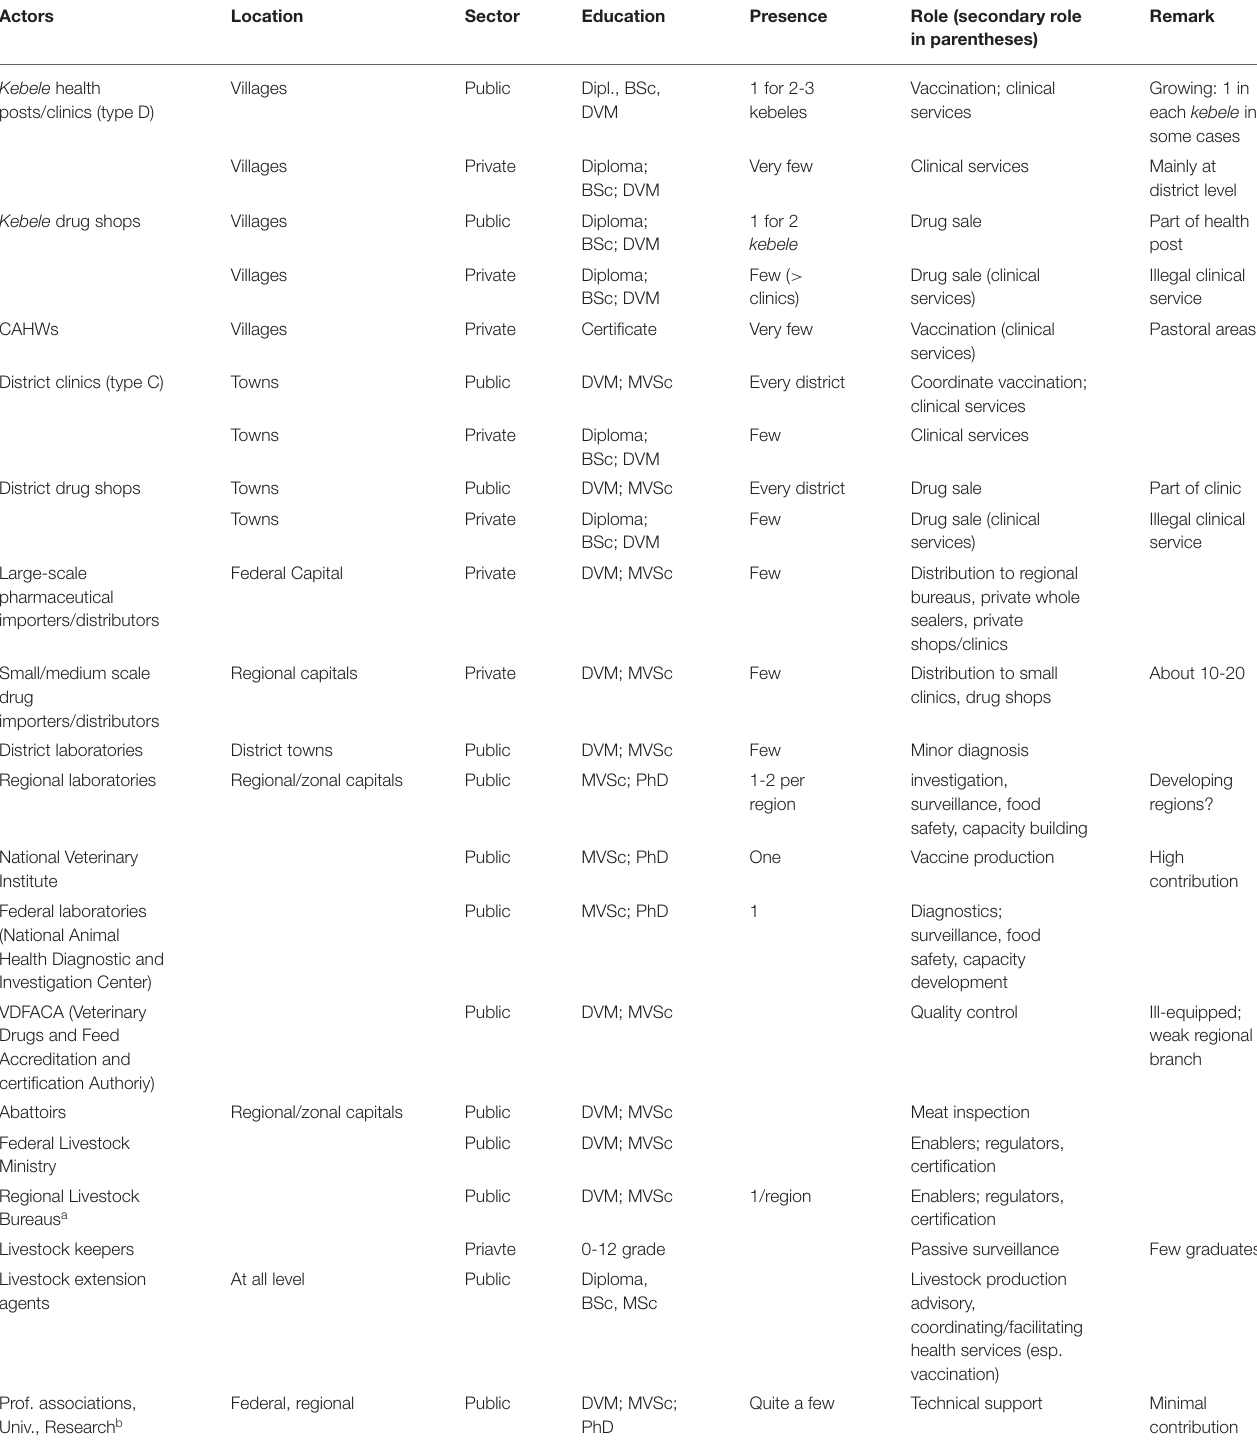
TABLE 2 | Value chain analysis of animal health service delivery (actors and roles) in